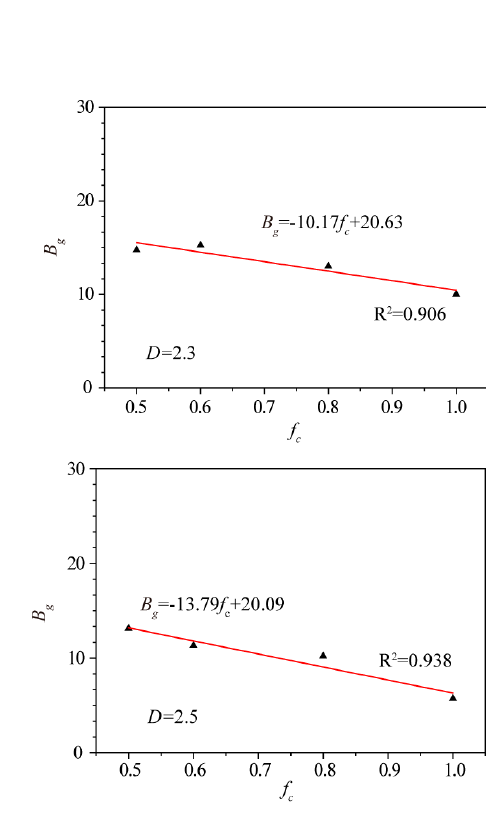
Figure 13. Changes of particle breakage index B g with f c under fractal dimension D = 2.3 and 2.5.